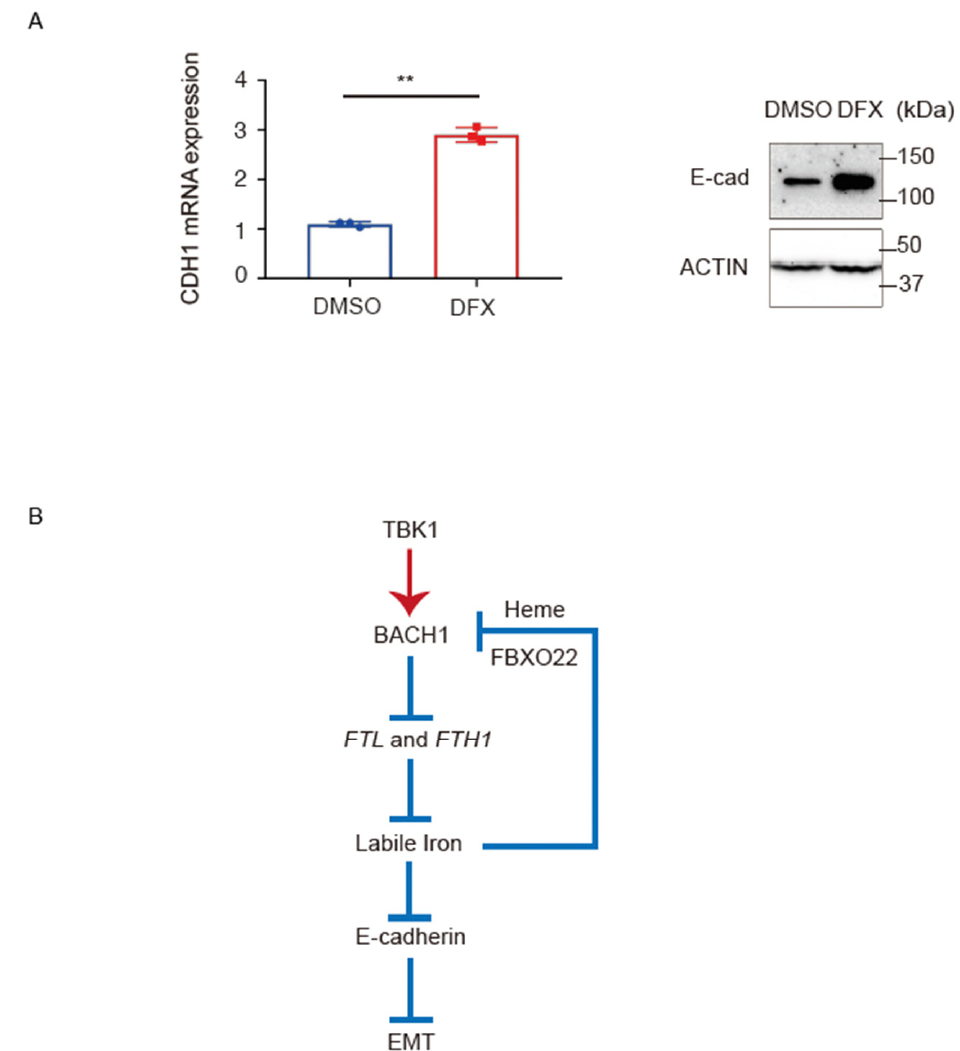
Figure 5. The increases of E-cadherin mRNA and protein under iron deficiency. ( A ), CDH1 mRNA (left) and protein (right) levels. AsPC − 1 cells were incubated with DFX (50 µ M) or DMSO for 48 h. All data are presented as mean ± SD, with p values from the Student’s t -test. n = 3 biologic replicates for each experiment. **, p < 0.01. ( B ), Proposed model for the regulation of iron and BACH1 and their connection to the regulation of E-cadherin in pancreatic cancer cells.